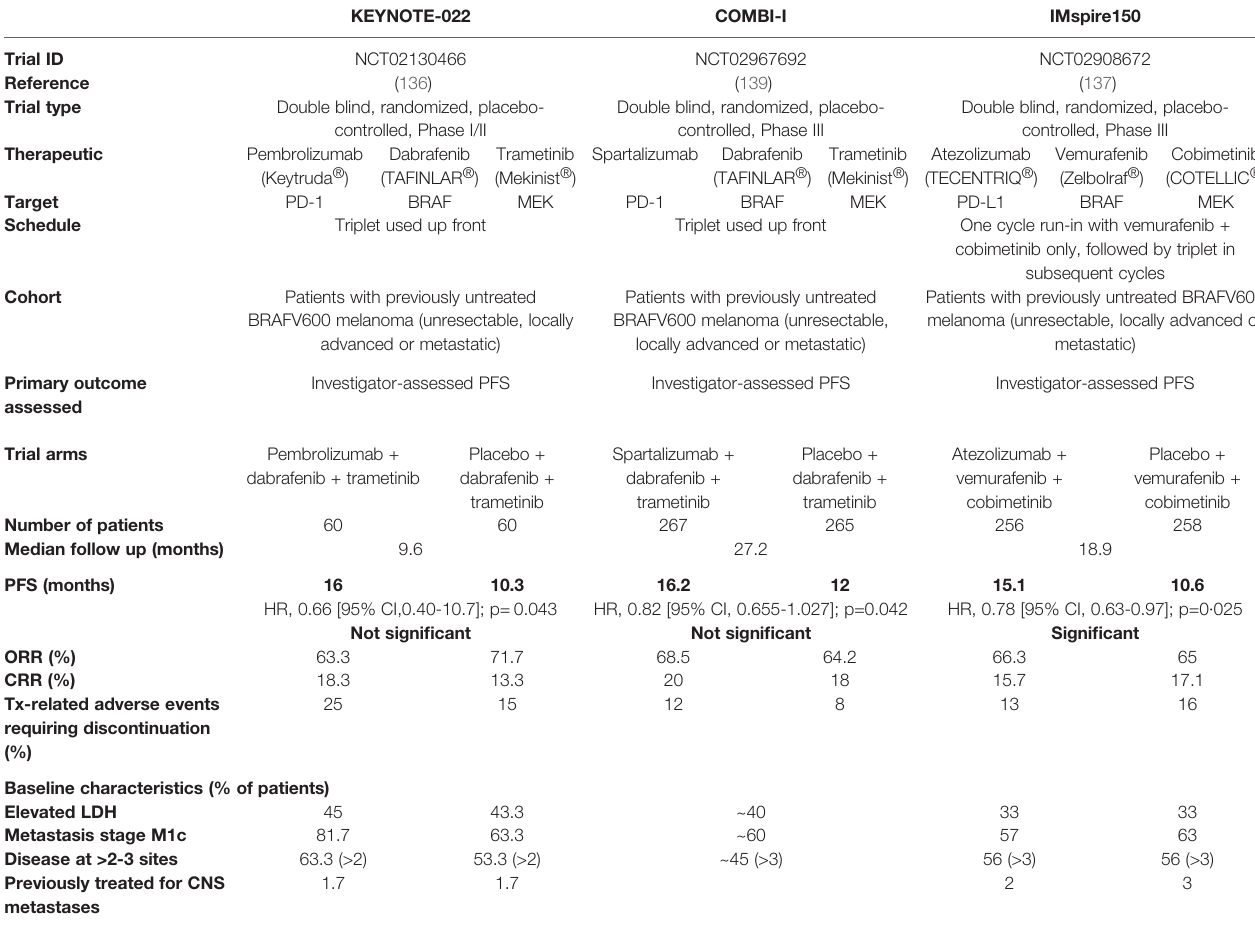
TABLE 1 | Design, results and key features of major clinical trials evaluating BRAF/MEK/PD-(L)1 triple combination therapy.